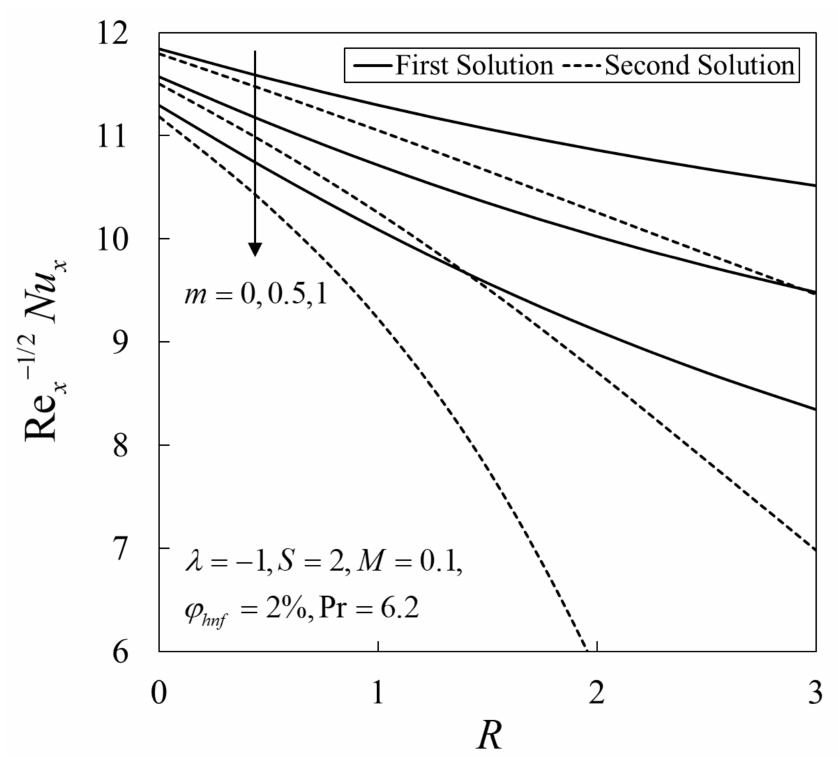
Figure 2. Variations of the local Nusselt number Re − 1/2 x Nu x against the radiation parameter R for different values of m .